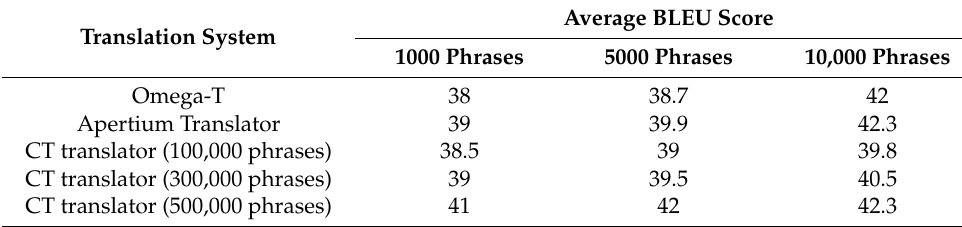
Table 4. Automated evaluation using BLEU Score, for the English-French corpora.